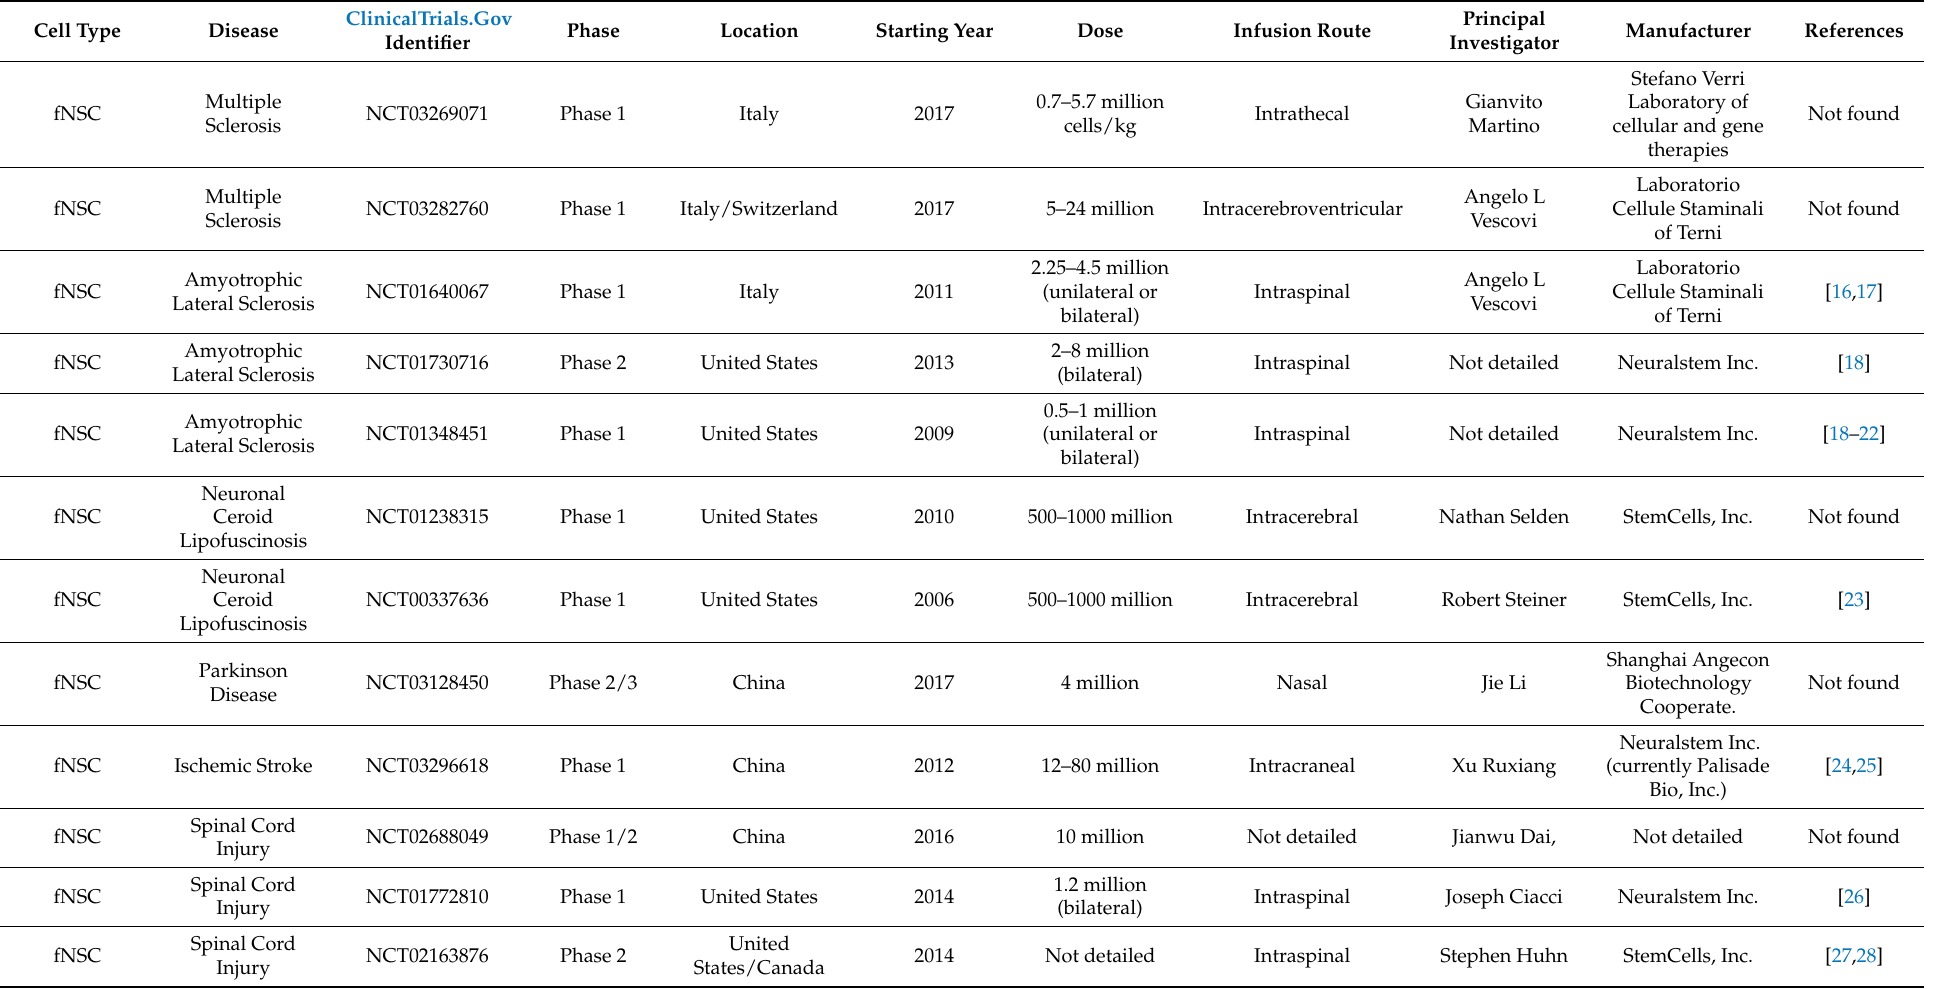
Table 1. Clinical trials with neural stem